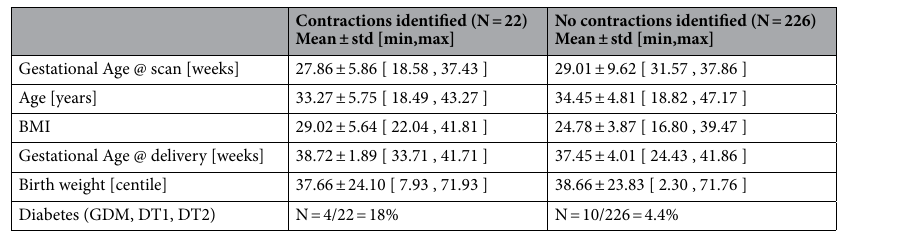
Table 1. Cohort statistics of the observed contractions with sufficient temporal T2*